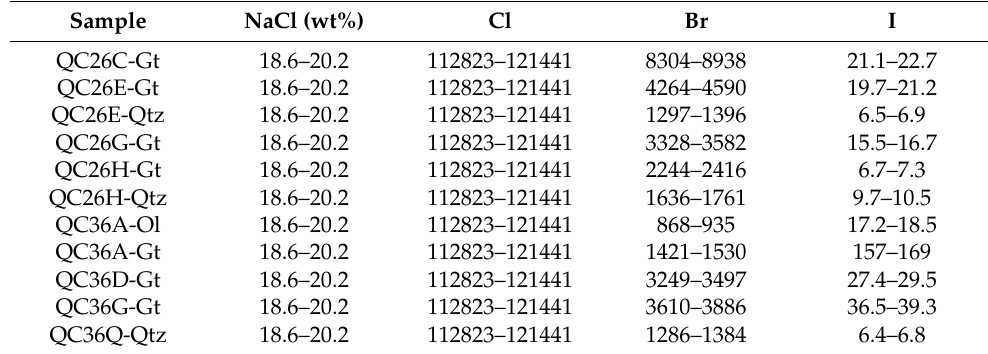
Table 6. Reconstructed halogen compositions of garnet-hosted fluid inclusions